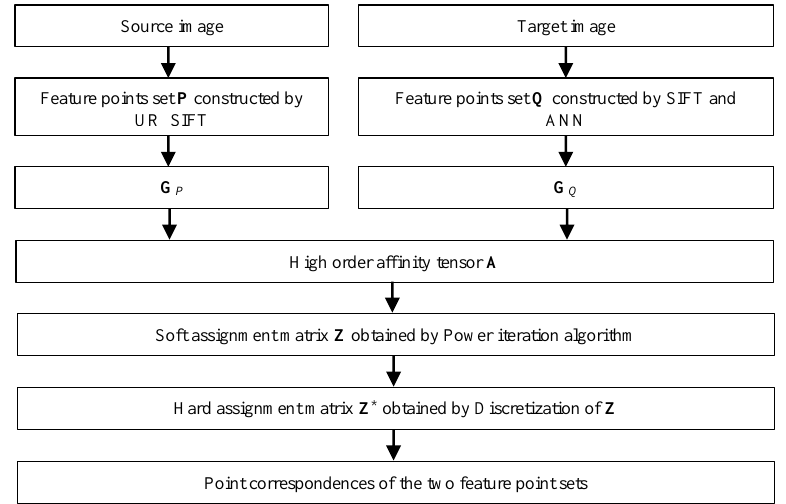
Figure 1 The workflow of graph based image